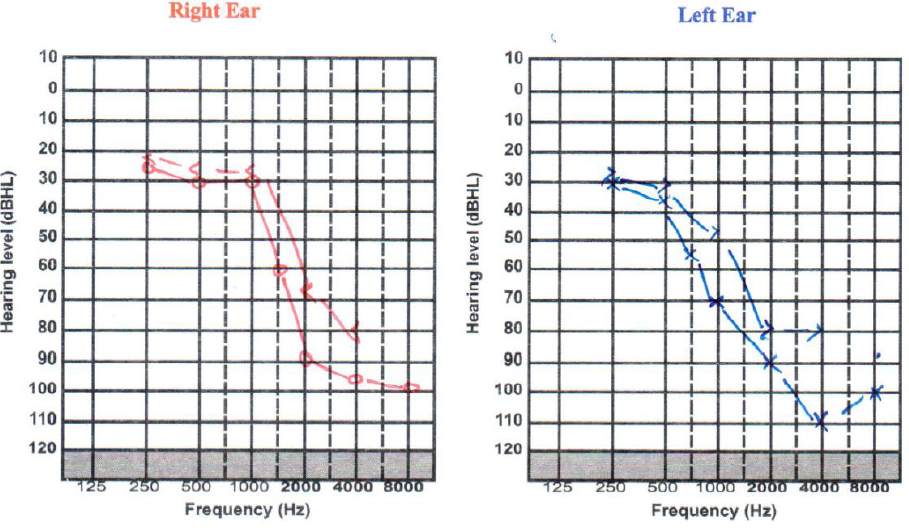
Figure 5. Subject audiogram chart.